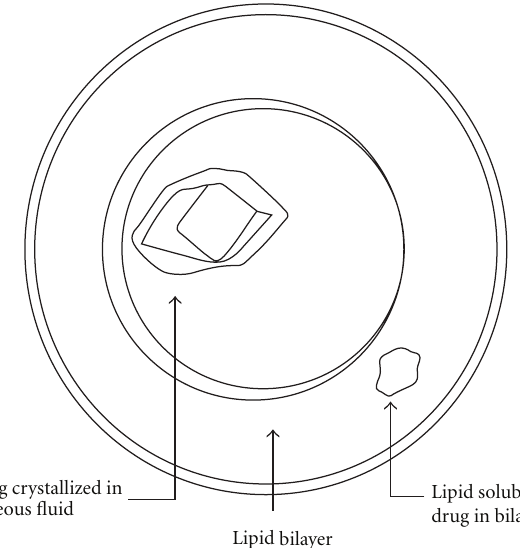
Figure 7: Liposome for drug